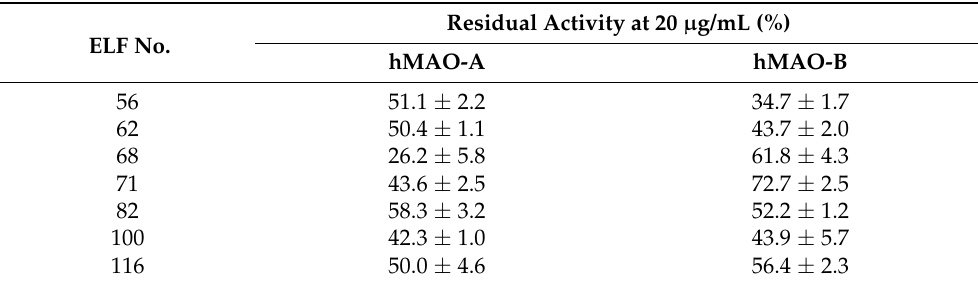
Table 1. Inhibitory activities of ELF extracts against hMAO-A and hMAO-B. ELF